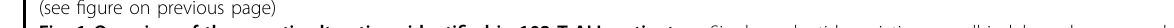
KRAS ( n = 6, 5.9%), EZH2 ( n = 5, 4.9%), and SH2B3 ( n =